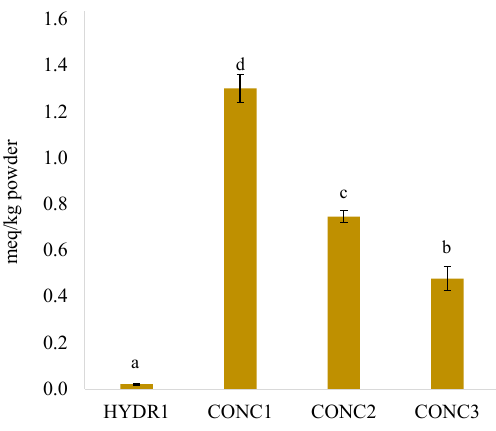
Figure 4. Peroxide values (meq/kg protein powder, “as is”) in three commercial fish protein concentrate (CONC1–3) and a hydrolysate (HYDR1). Different letters indicate a statistically significant difference with ANOVA post hoc pair comparison ( p < 0.05).